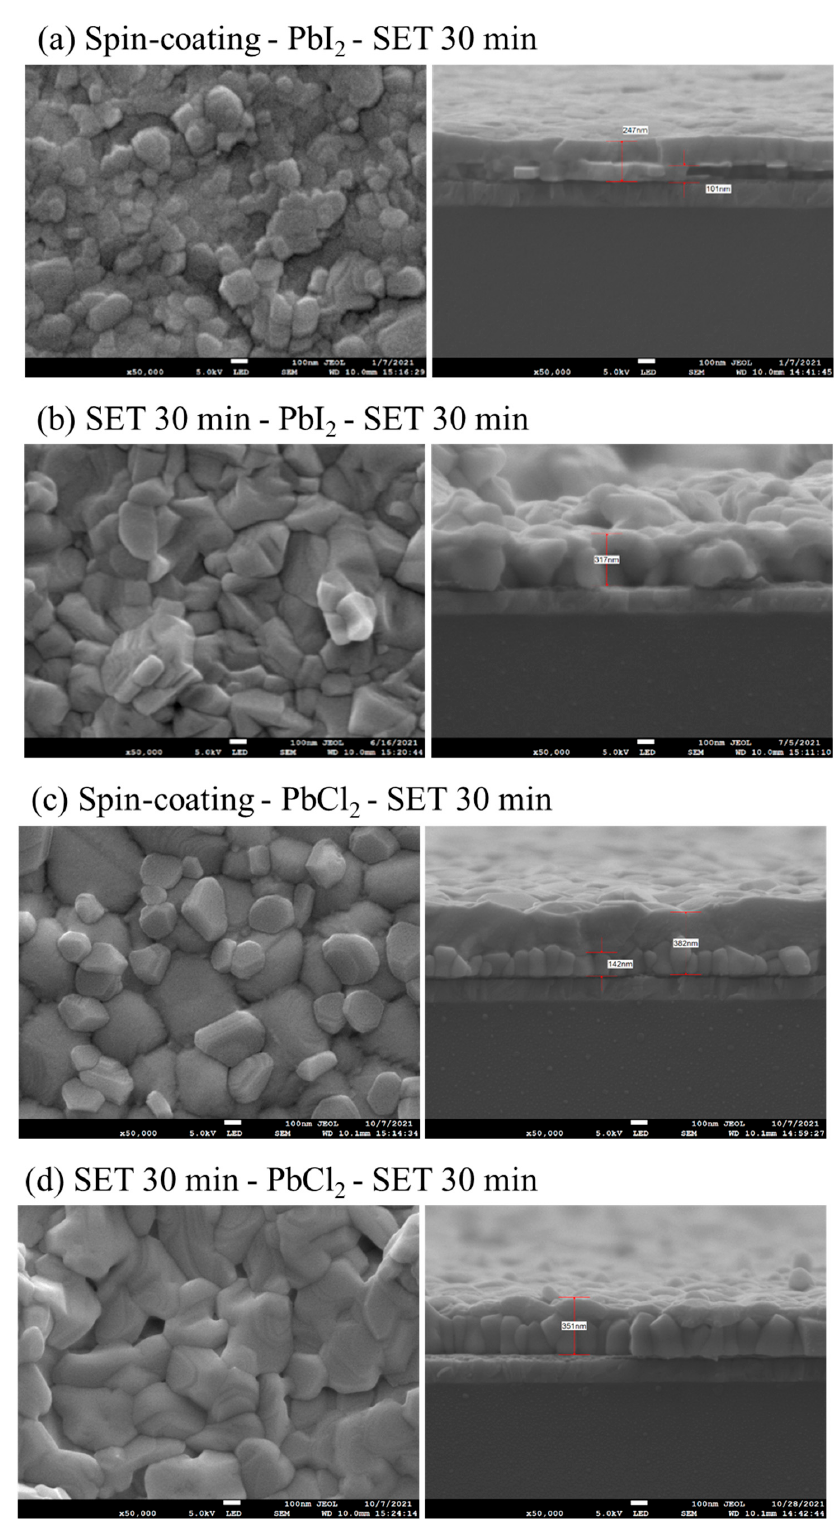
Figure 4. Top-view and cross-section SEM images at 50,000× magnification ( a – d ).